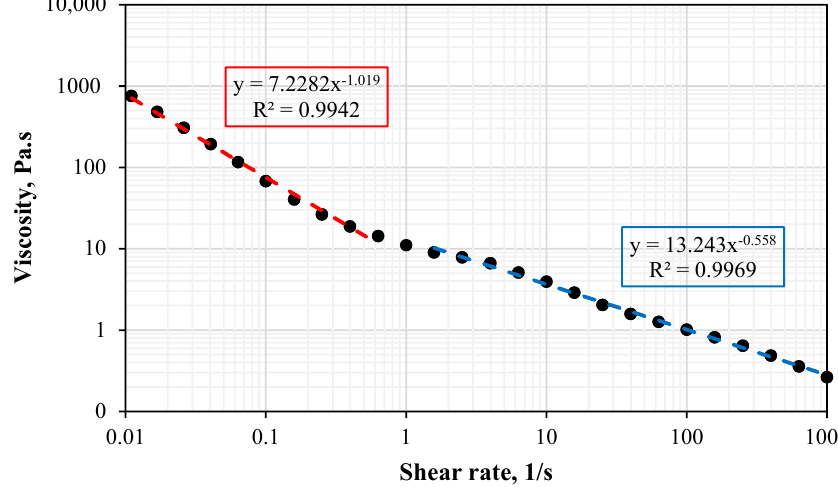
Figure 5. Flow behavior of CuAc gels at a pH of 10.4 and 25 °C.